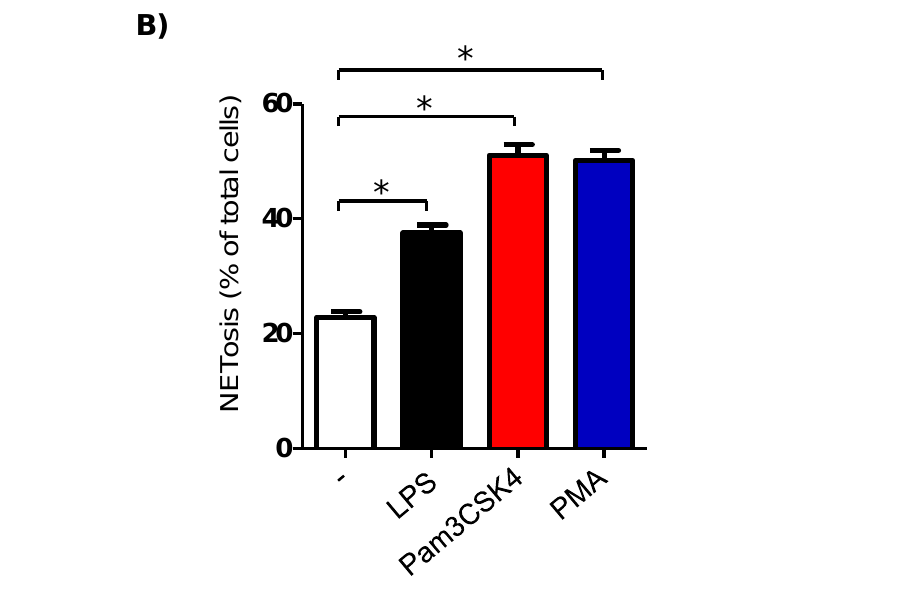
Figure 5. Flow cytometric analysis of NET-formation (NETosis) in milk cells. Cells were separated from unstimulated and stimulated milk samples, stained with Cytox Green, and analyzed by flow cytometry. ( A ) Here, NET-formation was identified based on the enhanced green fluorescence in FL-1. ( B ) The percentage of cells with NET-formation was calculated for stimulated and unstimulated milk cells and presented graphically ( n = 7 camels). * indicates statistically significant differences between the groups ( n = 7 camels; p values less than 0.05).